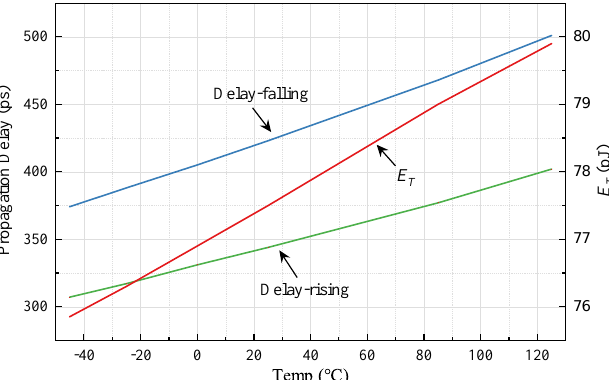
Figure 12. Propagation delay and E T versus temperature